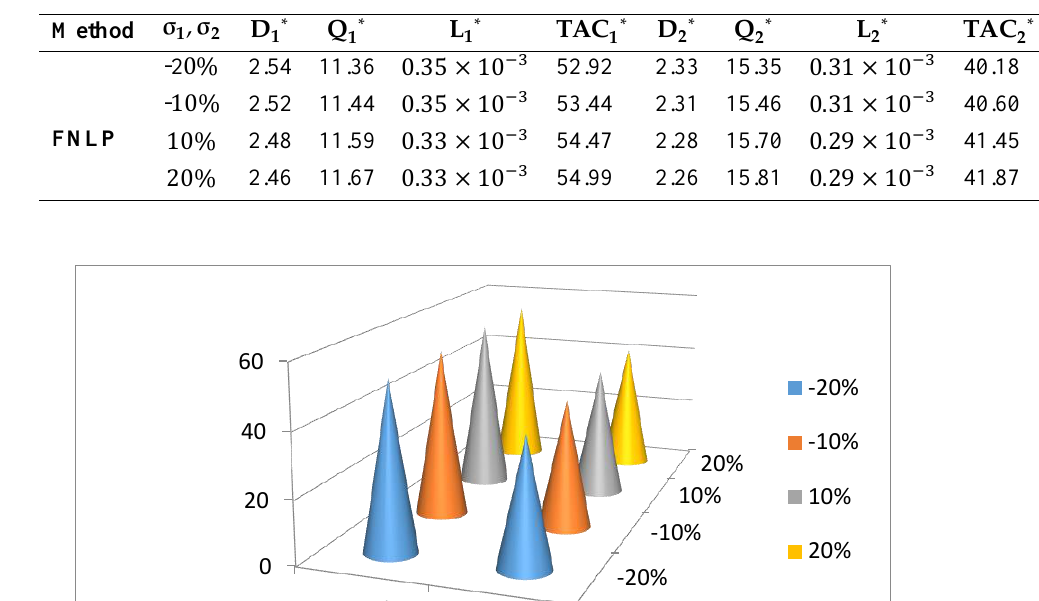
Table 7. Optimal solutions of MOIM for different values of 𝛔 𝟏 , 𝛔 𝟐 .